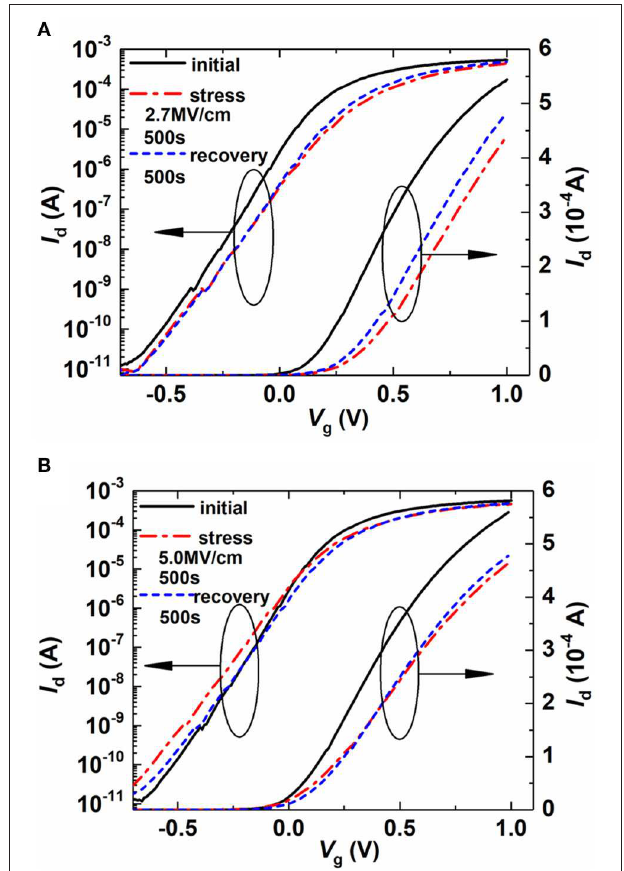
FIGURE 5 | DC I d – V g curves of buried In 0.25 Ga 0.75 As channel n-MOSFETs after (A) 500s of PBTI stress ( E = 2.7 MV/cm) and (B) PBTI stress ( E = 5.0 MV/cm) followed by 500s of